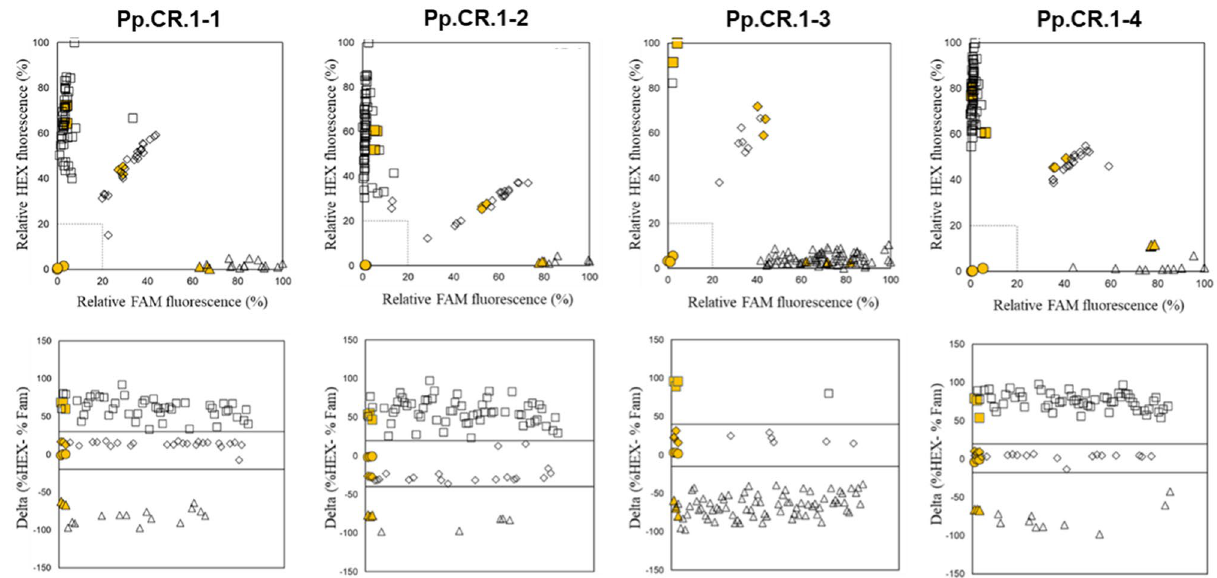
Figure 1. Validation of the Ppe.CR.1 KASP assays in the U.S. peach breeding germplasm. Yellow shapes show positive controls, empty shapes show unknowns, with the shape indicating the assigned genotype as follows: circle = no template/no amplification, triangle = AA, diamond = AB, square = BB. Dashed lines in plots in the top row demonstrate bounds for no amplification (% fluorescence < ~ 20% for both fluorophores). Dashed lines in plots in the bottom row indicate delta value.